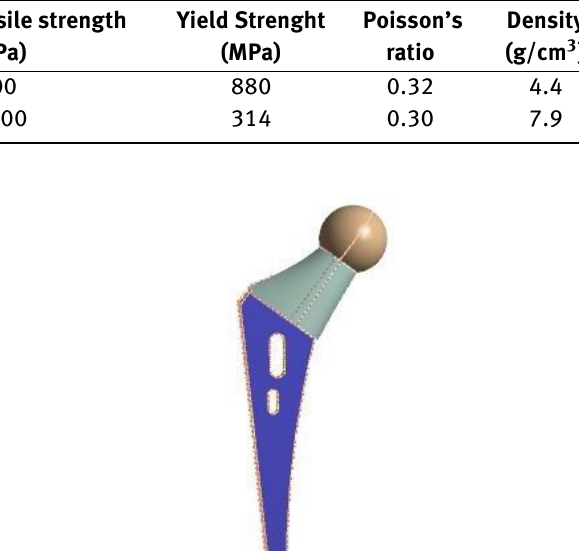
Table 1: Mechanical Properties of Materials [16, 17]